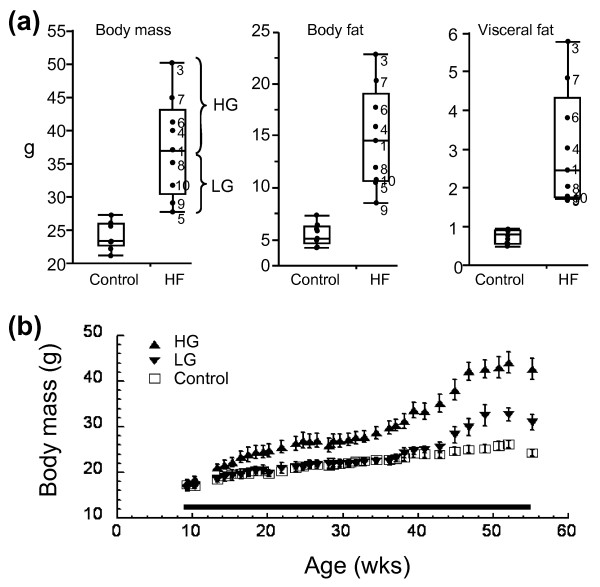
Diet-induced changes in body mass and fat levels in control and high-fat fed mice. (a) High-fat (HF)-fed mice showed much greater levels of variation in body mass, body fat, and visceral fat compared with control mice. The same individual HF mice (denoted numerically) fell in either the upper half or lower half of the bar plot distributions for these variables. Those mice in the upper half of the distribution were classified as high gainers (HG), and those in the lower half were classified as low gainers (LG). (b) Body mass in HG mice was greater than controls after 4 weeks of HF feeding compared with 37 weeks of HF feeding in LG mice (P < 0.05). Bar indicates duration of HF feeding. Data shown as mean ± standard error of the mean.